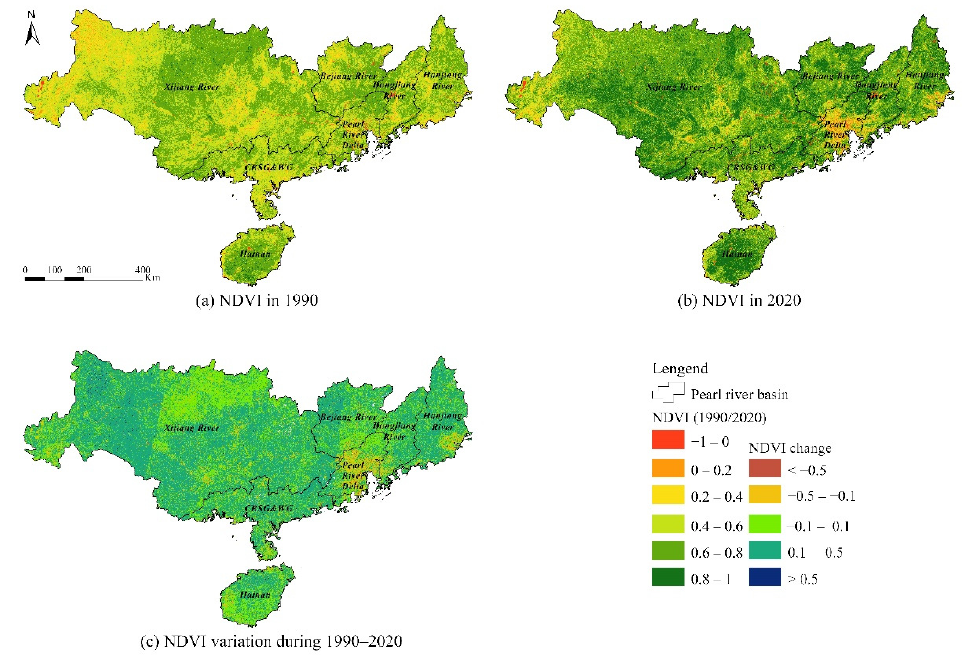
Figure 7. NDVI dynamics (1990–2020): ( a ) NDVI status in 1990, ( b ) NDVI status in 2020, ( c ) NDVI variation during 1990–2020.